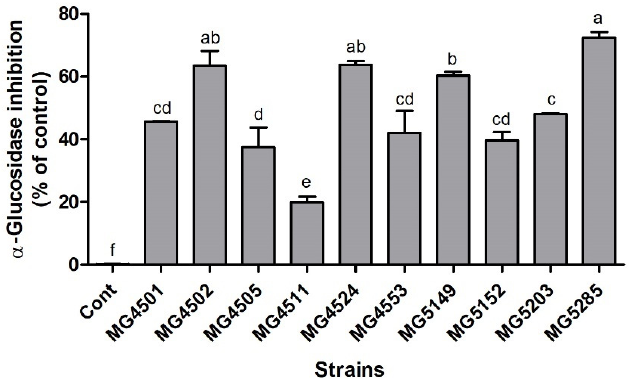
Figure 2. α -Glucosidase inhibitory activity of probiotic candidates. All values are presented in comparison with the control and as the means ± SD from three independent experiments. The control was measured by adding a buffer instead of LAB. Different letters indicate significant differences between means at p < 0.05 by Tukey’s multiple comparison tests. Cont; control.